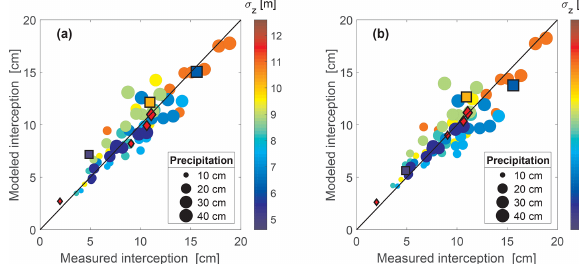
Figure 4. Measured and parameterized site means of intercepted snow depth, i.e., spatially averaged over each site and for each storm date. Parameterized using (a) Eq. (2) and (b) Eq. (3) as a function of the site means of standard deviation of the lidar DSM σ z (in color) as well as open-site snowstorm precipitation (size of symbols). Cir- cles represent the development data set from Switzerland, symbols with a black border represent the validation data sets with squares for that from the US, and diamonds for data sets from